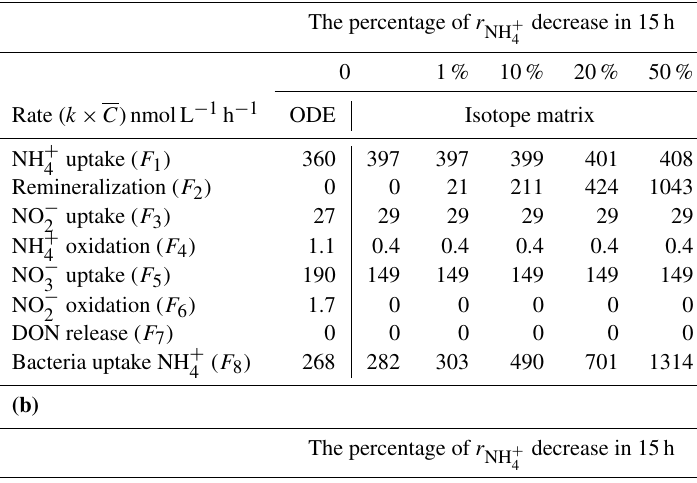
Table 2. The isotope matrix results for the rates of N processes in the high-nutrient case at the depth of (a) 80% sPAR and (b) 2% sPAR under different r variation conditions. In addition, all N transformation rates via ODE following Pfister et al. (2016) on the assumption NH + 4 of no remineralization were estimated for comparison. Note: r variation was manipulated artificially by decreasing r NH + 4 constant reduction rate and the total reduction of r was 0, 1, 10, 20, and 50% of the full time span (15h) of NH + 4